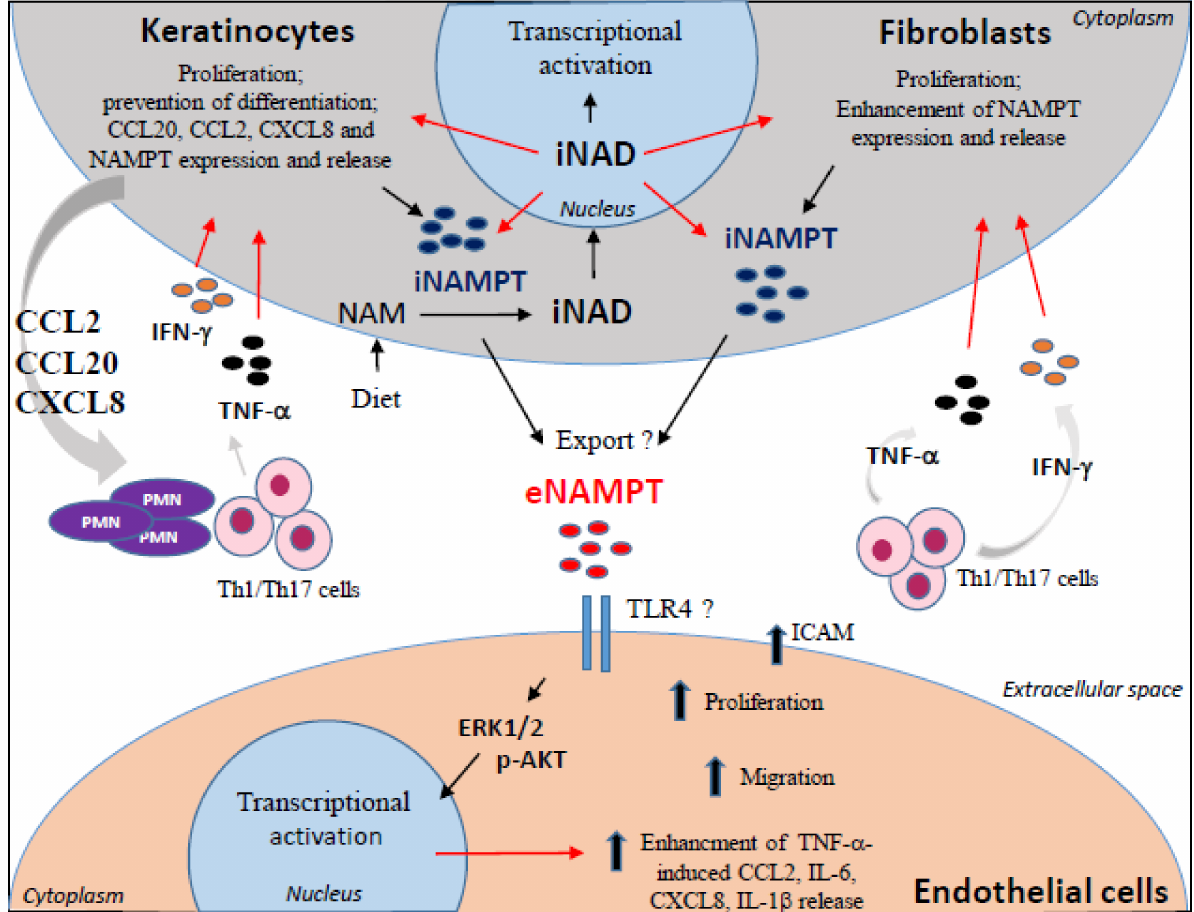
Figure 8. Model emphasizing the role of NAMPT-dependent NAD metabolism on the pathogenic crosstalk between keratinocytes, fibroblasts, and dermal endothelial cells in psoriatic skin. Psoriatic skin lesions are characterized by a high intracellular NAD+ boosting, compared to uninvolved skin. Accumulation of the intracellular NAD contributes to the enhancement of IFN- γ /TNF- α -induced release of inflammatory cytokines, such as CCL2, CCL20, and CXCL8, by keratinocytes, which fuel an auto-inflammatory loop by recruiting Th17/Th1 subpopulations and polymorphonuclear leukocytes (PMN). The high intracellular NAD levels also lead to keratinocyte hyperproliferation and impaired differentia- tion, thus contributing to the epidermal thickening typical of psoriatic skin lesions. Furthermore, upon exposure to IFN- γ and TNF- α cytokines, keratinocytes and dermal fibroblasts release high amounts of NAMPT, which is exported to the extracellular space by unknown mechanisms. The high intracellular NAD levels contribute to the induction of NAMPT expression in keratinocytes and fibroblasts. Keratinocyte- and fibroblast-released extracellular NAMPT (eNAMPT) acts on dermal endothelial cells in a paracrine fashion, by inducing their proliferation and migration, which contribute to a dysreg- ulated angiogenesis. Finally, eNAMPT enhances TNF- α -induced expression of ICAM1 on membrane of endothelial cells, as well as their release of CCL2, CXCL8, and IL-6, which contribute to the extravasation and recruitment of inflammatory immune infiltrate into inflamed